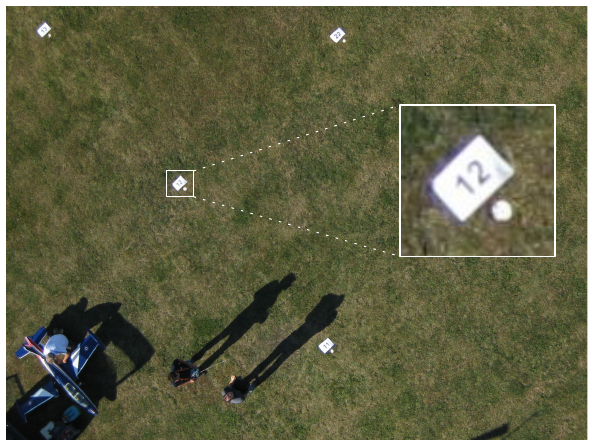
Figure 2: Example of an UAV (flying height: approx. 25m) image with an exposure time of 1/1000s. Notice the low sun angle. The insert zooms to a control point used for evaluation. The control point ID is printed on an A4